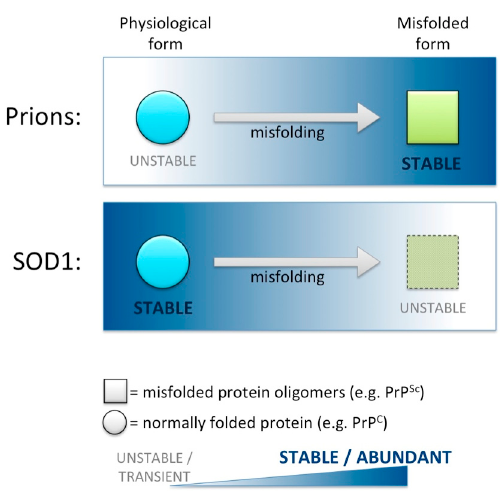
Figure 7. When comparing their physiological and misfolded forms, the stability profile of SOD1 is inverted compared to Prion Protein. Top: Properly folded Prion Protein (PrP C , the normal physiological cellular form) has a typical protein stability and proteostatic clearance kinetics, whereas the misfolded scrapie form (PrP Sc ) is infamously stable. The extreme stability of misfolded prion PrP Sc creates important challenges in clearing BSE (bovine spongiform encephalopathy) from contaminated agricultural fields, clearing CWD (Chronic Wasting Disease) from deer habitats/ecology, and disinfecting surgical instruments. Bottom: SOD1 is now appreciated as being prion-like, and we note it as an exemplar of protein functions being lost during etiology, in part because its proteostatic profile is opposite that of prion protein. Physiological normally folded SOD1 is extremely stable, such that it infamously can be recovered in active form from ancient mummified remains. Misfolded SOD1 is remarkably unstable such that it is reduced in function, in sharp contradistinction to PrP Sc